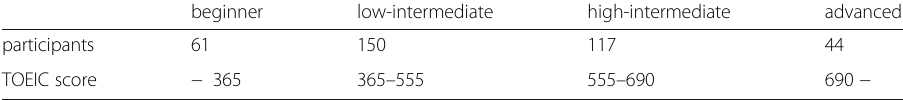
Table 1 Number of participants and TOEIC